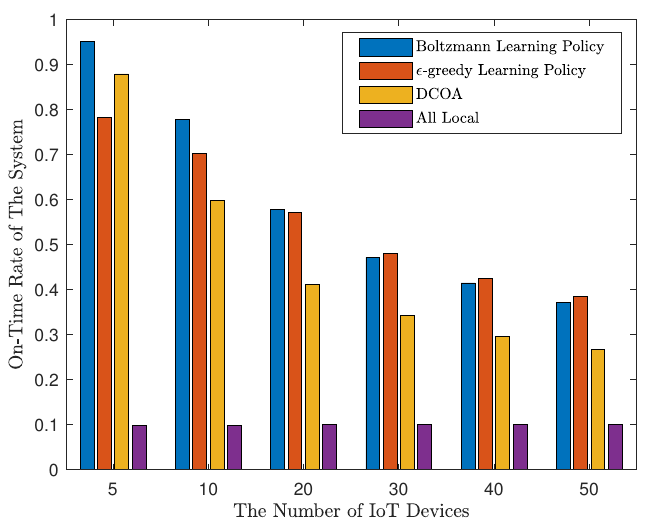
Figure 3. On-time rate of IoT